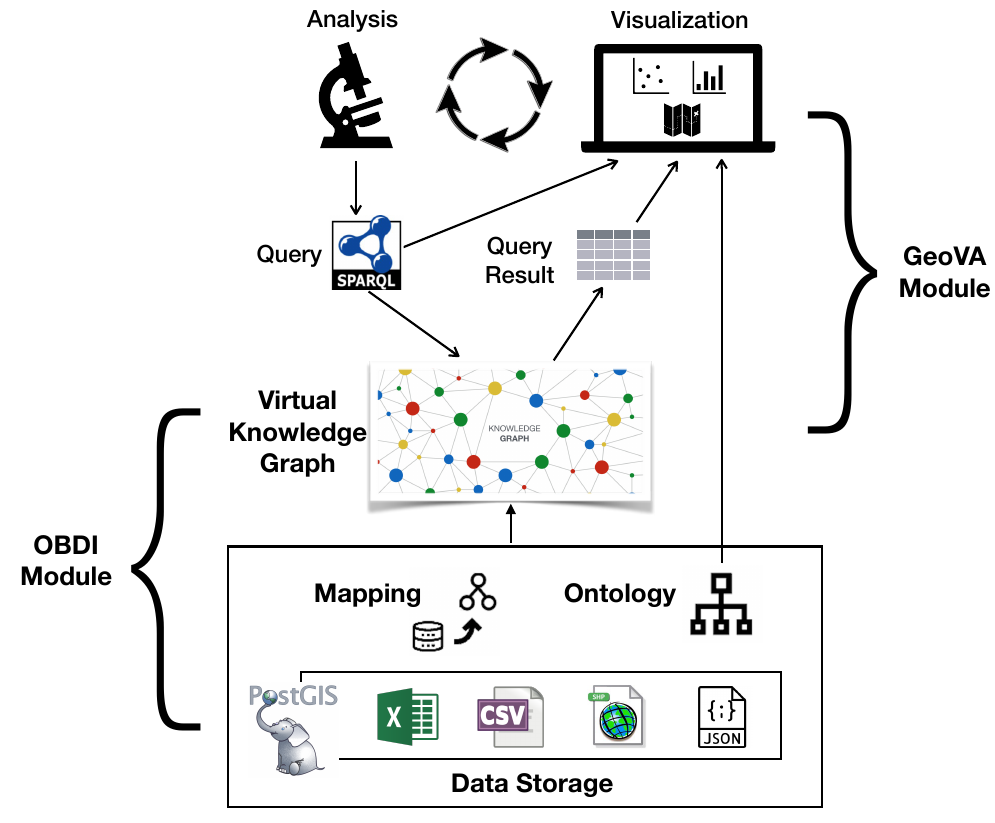
Figure 1. The Ontology-based Geodata Integration for Geovisual Analytics ( GO d IVA )